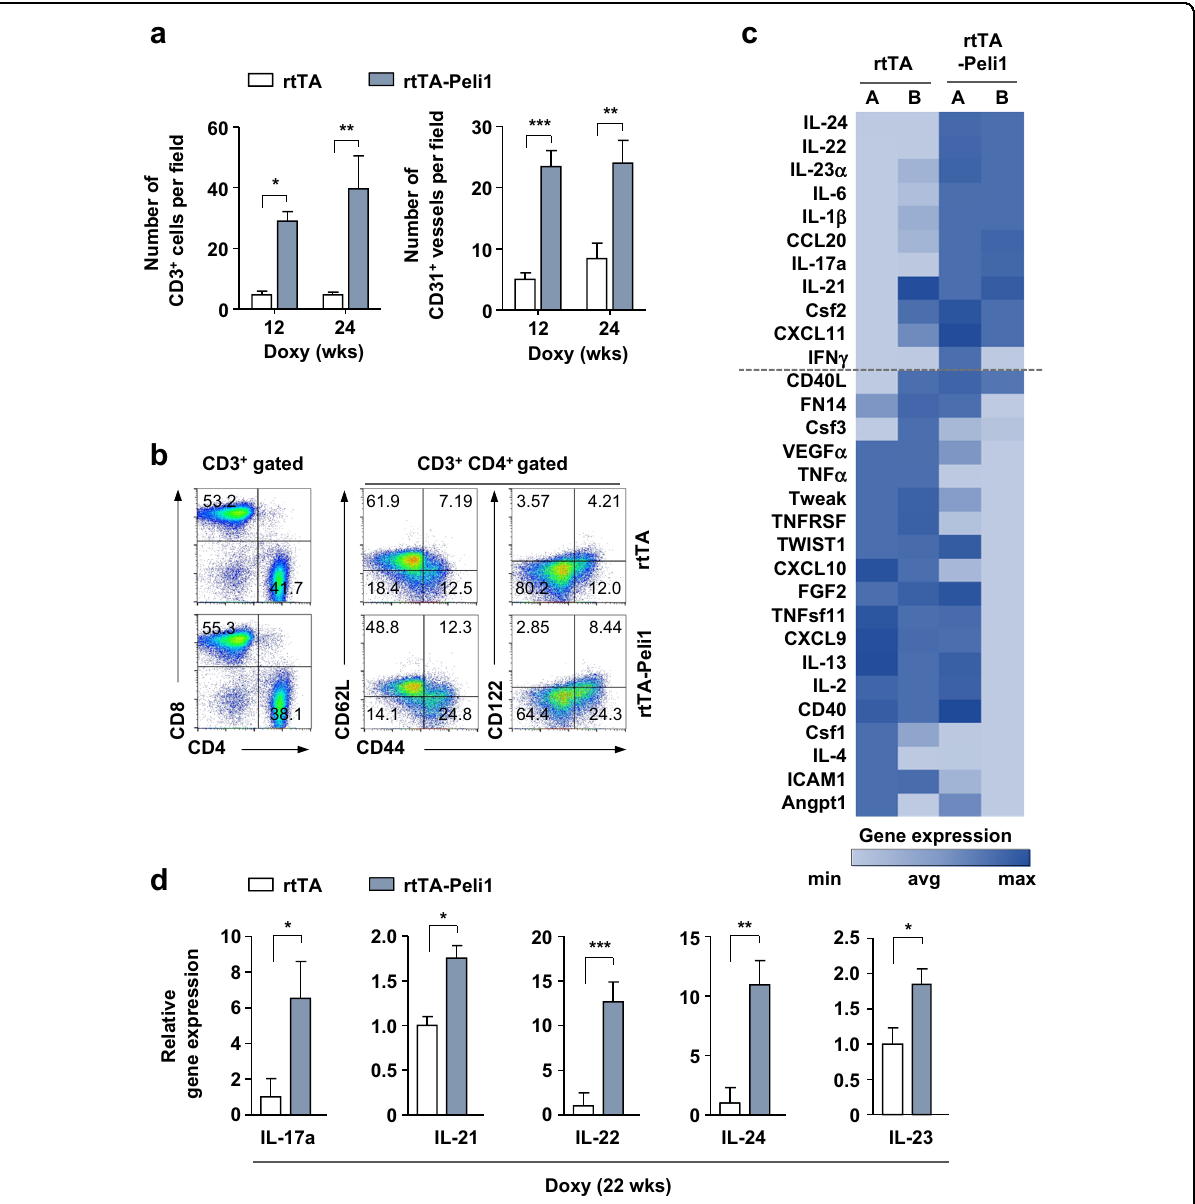
Fig. 4 Peli1 induces the development of psoriasis-like disease via a Th17 cell response. a Adult rtTA control mice and rtTA-Peli1 inducible transgenic mice were treated with doxycycline (2 mg/mL) for 12 and 24 weeks. Quanti fi cation of CD3 + cells and CD31 + vessels based on fi ve skin sections obtained from fi ve independent mice with the indicated genotypes ( n = 3 mice per genotype). b Flow cytometry of T cells derived from rtTA and rtTA-Peli1 mice following treatment with doxycycline for 24 weeks. Immunocytes were isolated from the draining lymph nodes (inguinal, axillary, brachial, and cervical lymph nodes) of rtTA and rtTA-Peli1 mice. Cells were stained with CD3, CD4, CD44, CD62L, and CD122, followed by fl ow cytometry. Gated CD3 + CD4 + T cells were analyzed for CD62L, CD44, and CD122 expression. c Heat map depicting real-time quantitative PCR (qRT- PCR) analysis of in fl ammation-related genes in skin samples obtained from doxycycline-treated rtTA and rtTA-Peli1 mice (two representing each genotype). Genes were ranked based on fold change in expression. The expression of genes above the dashed line was highly elevated in lesional skin samples derived from mice overexpressing Peli1 (rtTA-Peli1 mice with doxycycline treatment). d Comparison of Th17-related cytokine levels in doxycycline-treated rtTA and rtTA-Peli1 mice. Quantitative RT-PCR for cytokine expression was performed using skin tissues. Data are presented as the means ± SEMs ( n = 3). * P < 0.05, ** P < 0.01, *** P < 0.001; ns not signi fi cant; two-way